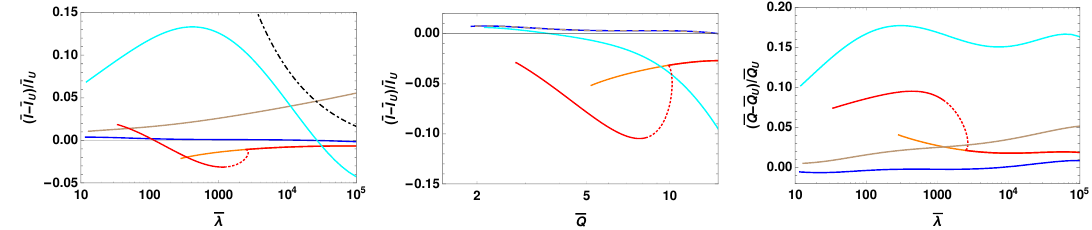
Figure 6 . The relative accuracy, to which the I-Love-Q universal relations of Yagi and Yunes [94] are reproduced by our (cid:12)ve example EoSs. The sub(cid:12)gures present the (cid:22) (cid:21) {(cid:22) I (left), (cid:22) Q {(cid:22) I (middle), and (cid:22) (cid:21) { (cid:22) Q (right) relationships, where the subscript U always indicates that the value of the quantity is taken from the corresponding universal relation. In the (cid:22) (cid:21) {(cid:22) I plot, the analytical curve is also shown as the black dot-dashed line, while for the other two cases this approximation falls outside the range chosen in the